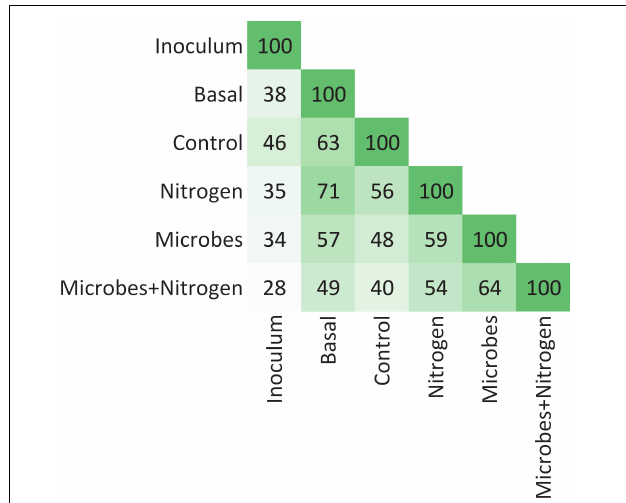
FIGURE 5 | Pairwise heatmap showing OTUs similarities between treatments. See section